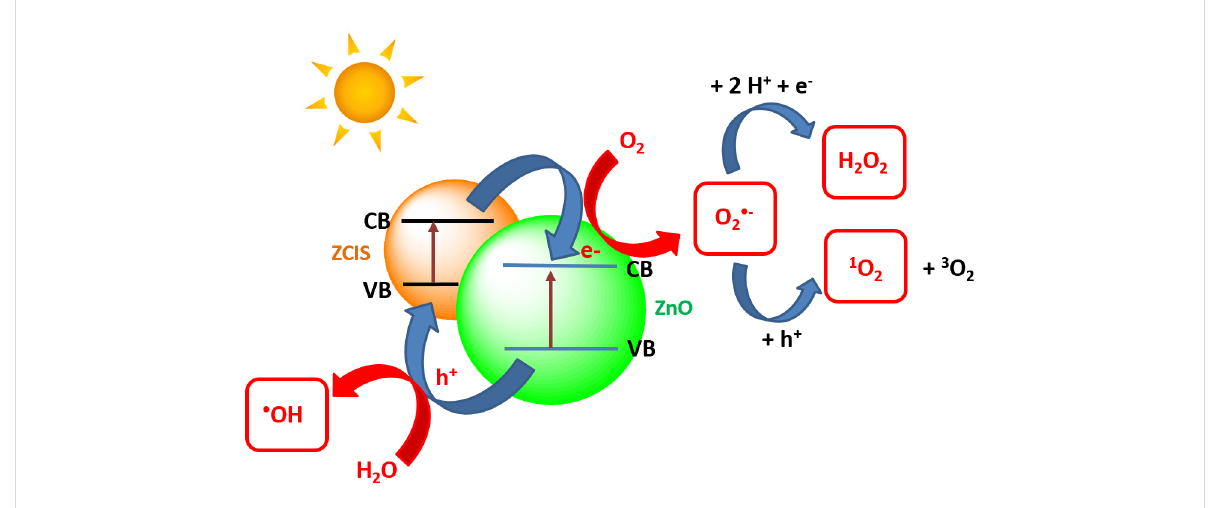
Figure 12: Schematic illustration of the charge transfer process and of the ROS production in the ZnO/ZCIS photocatalyst.